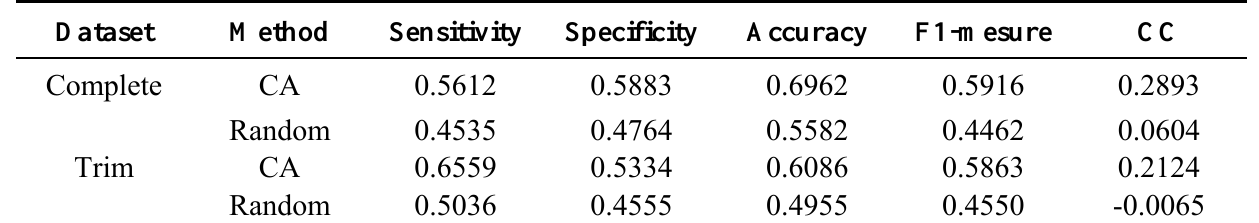
Table 1. Performances on a dataset of 61 protein chains using 5-fold